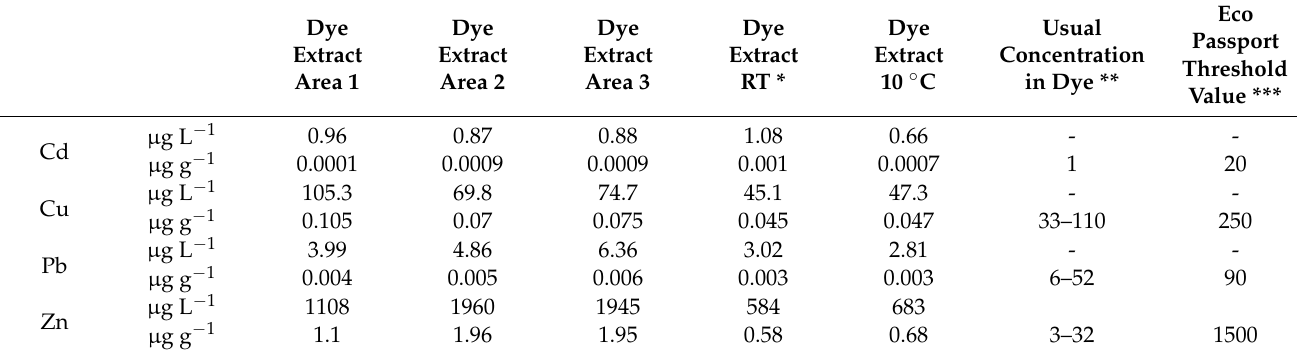
Table 5. TE concentration in the dye extract solution ( µ g L − 1 and µ g g − 1 of dye extract solution; n =